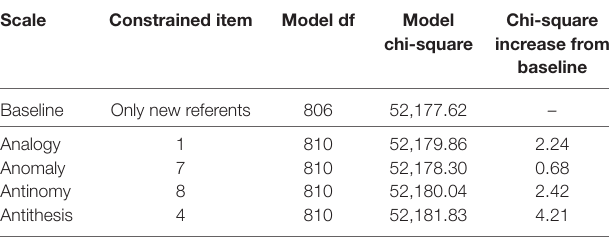
taBlE 5 | Likelihood-ratio tests for differential item functioning between language groups: testing